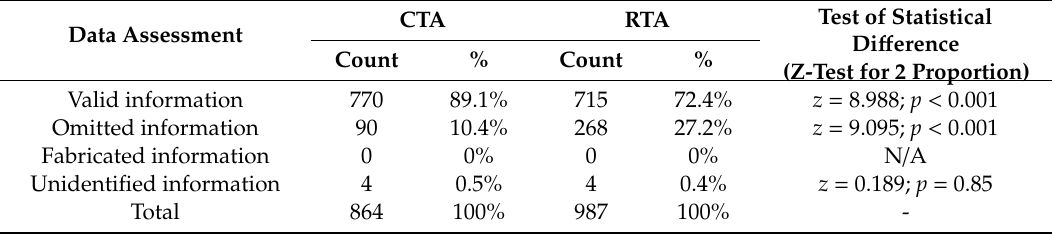
Table 5. Comparison of the data gathered by CTA and